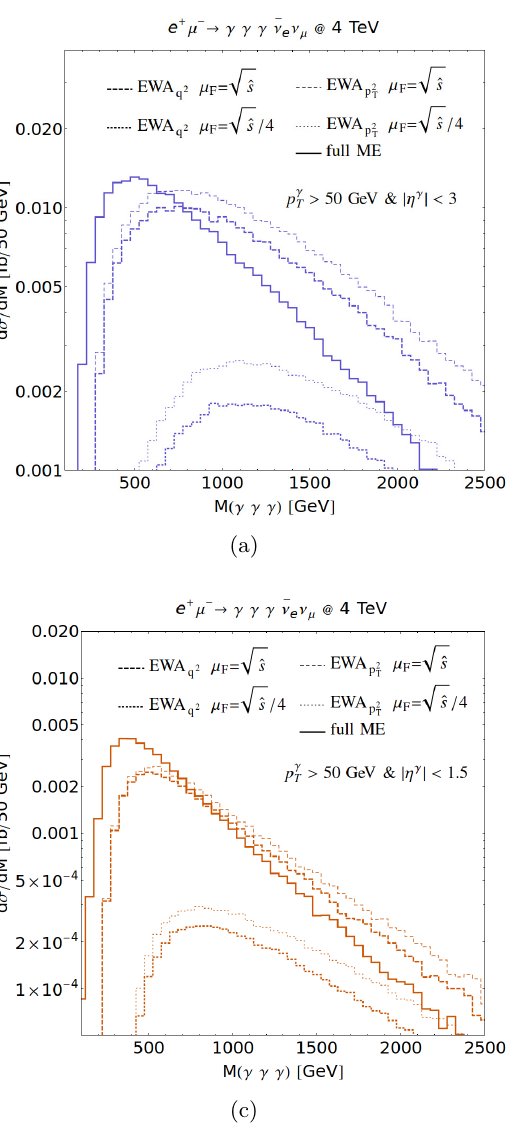
√ PDF W − → γγγ ME at s = 4 TeV , assuming f W T T T (thin lines), with µ = M ( γγγ ) f T √ s = 14 TeV . (c) The same as (a) > 150 GeV T